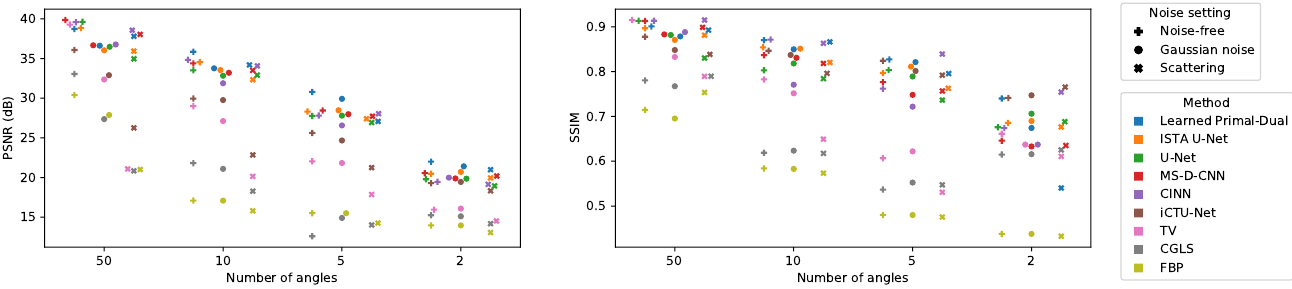
Figure A8. PSNR and SSIM compared for all noise settings and numbers of